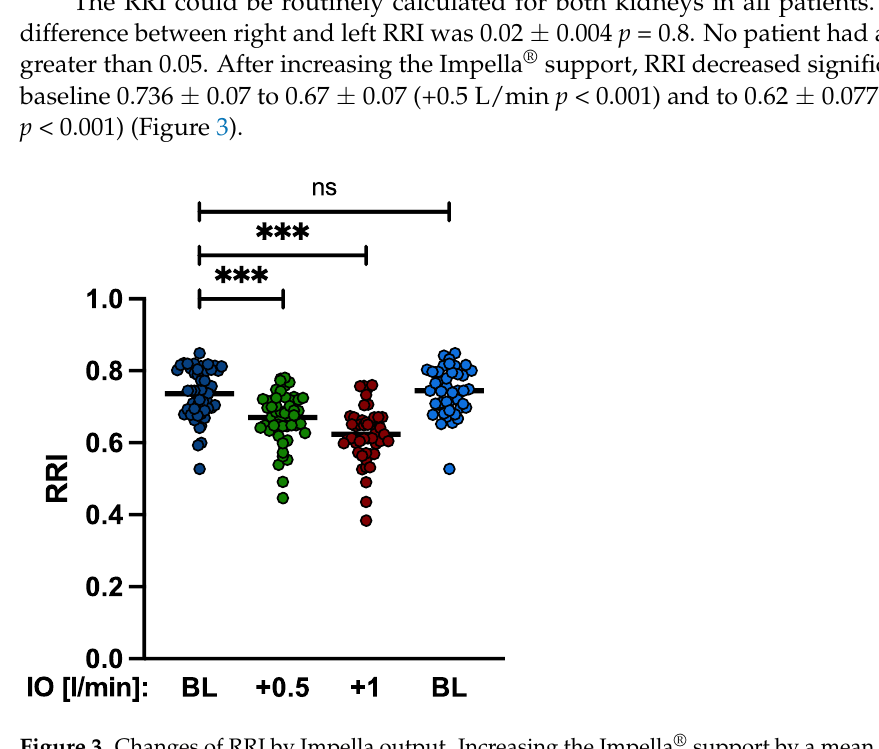
Figure 3. Changes of RRI by Impella output. Increasing the Impella ® support by a mean of 0.5 L/min and 1.0 L/min resulted in a significant reduction of the RRI from baseline 0.736 ± 0.07 to 0.67 ± 0.07 and to 0.62 ± 0.077, respectively. (IO: Impella ® output; BL: baseline; ns: not significant, p ≥ 0.5; ***: p < 0.001).